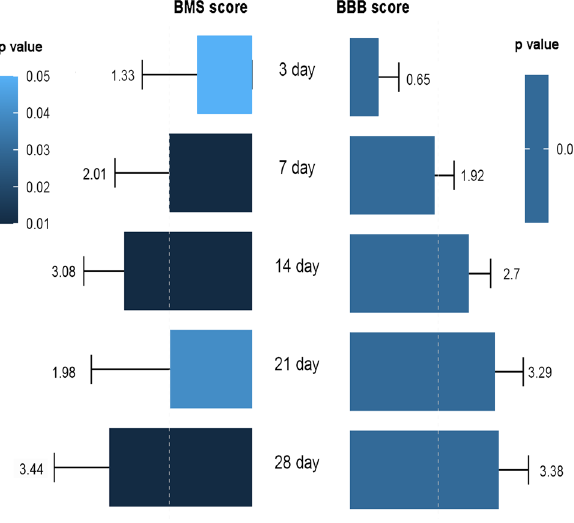
Figure 6: Locomotor function recovery of mice and rats on the 3rd, 7th, 14th, 21st, and 28th DPI. BBB, Basso, Beattie, and Bresnahan; BMS, Basso Mouse scale; DPI, day post injury; SMD, standard mean di ff erence.